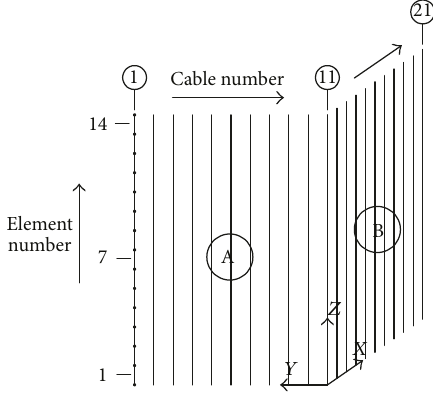
Figure 15: Number labels of cable and truss element.